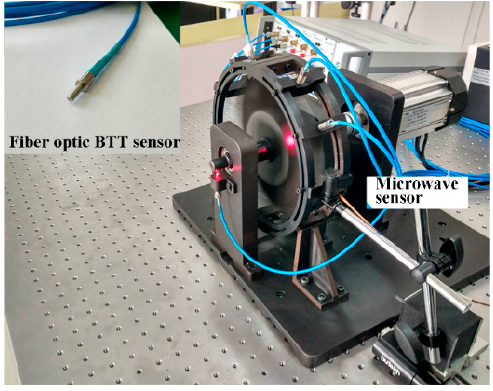
Figure 7. Test rig and fiber optic blade tip timing sensor (inset).